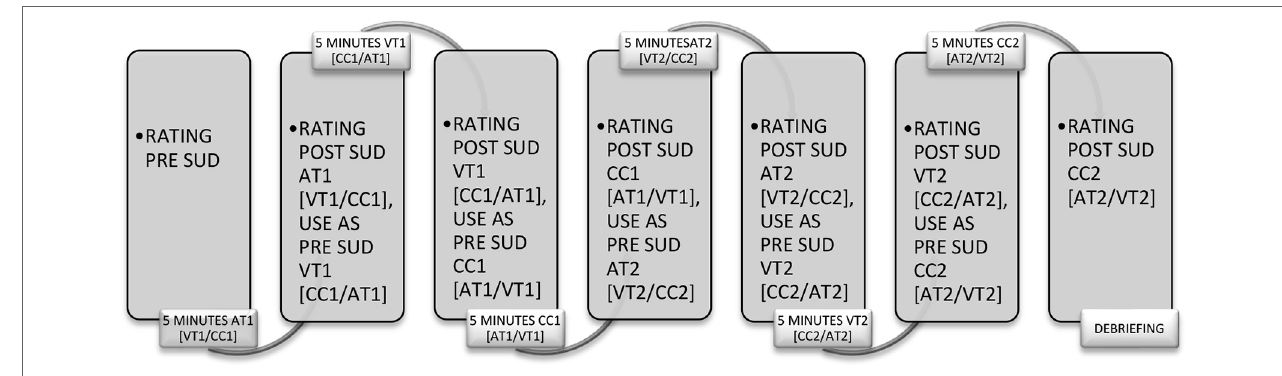
FIGURE 1 | Timeline of the procedure (SUD, Subjective Units of DisturbanceUD scores; VT, Visual Taxation; AT, Auditory Taxation; CC, Control